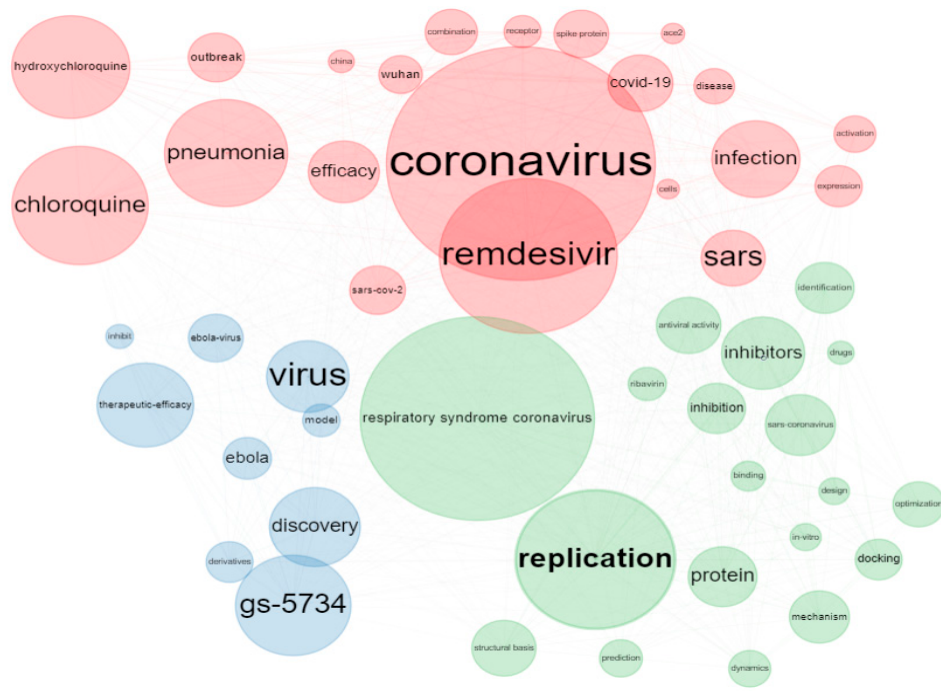
Figure 3. Keyword-co-occurrence-network visualization for remdesivir research.